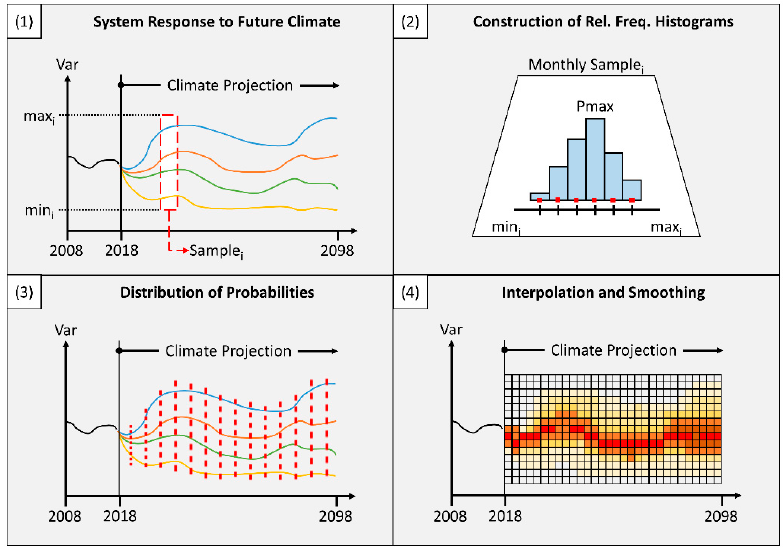
Figure 4. Processing steps for the groundwater levels and reservoir storage data.